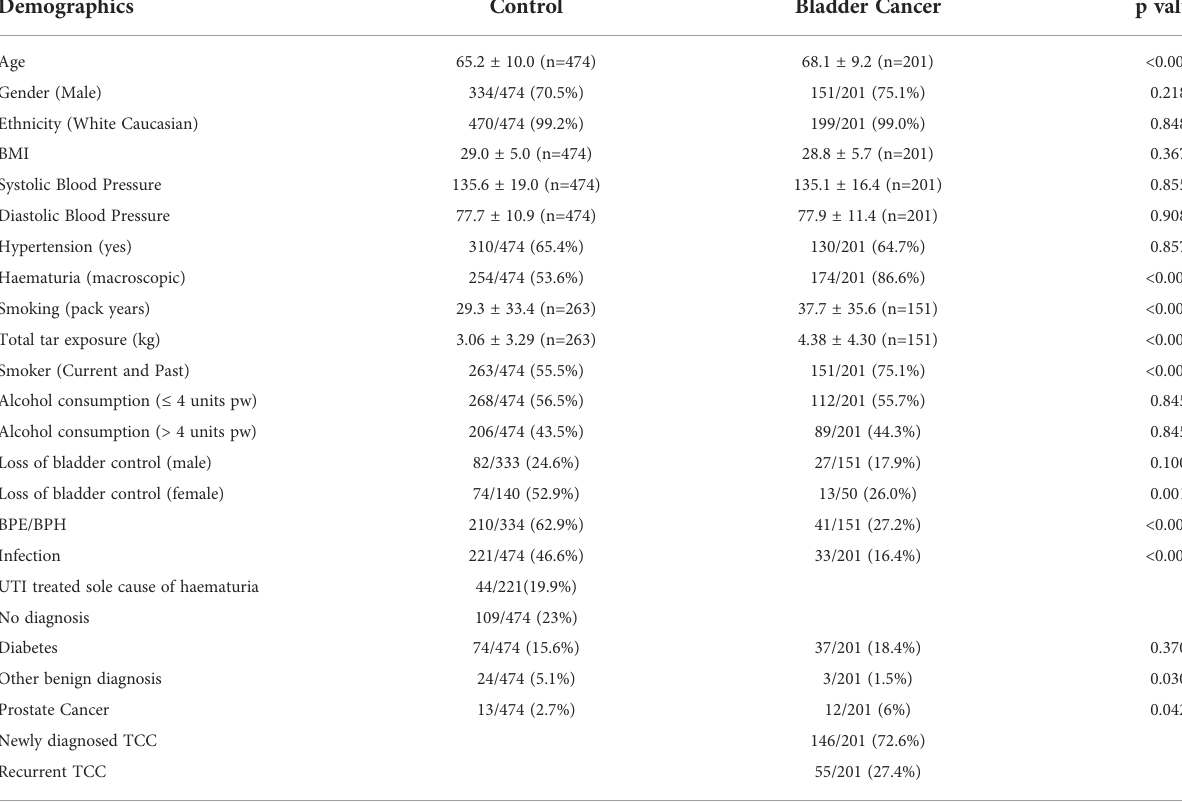
TABLE 2 HABIO patient demographics and